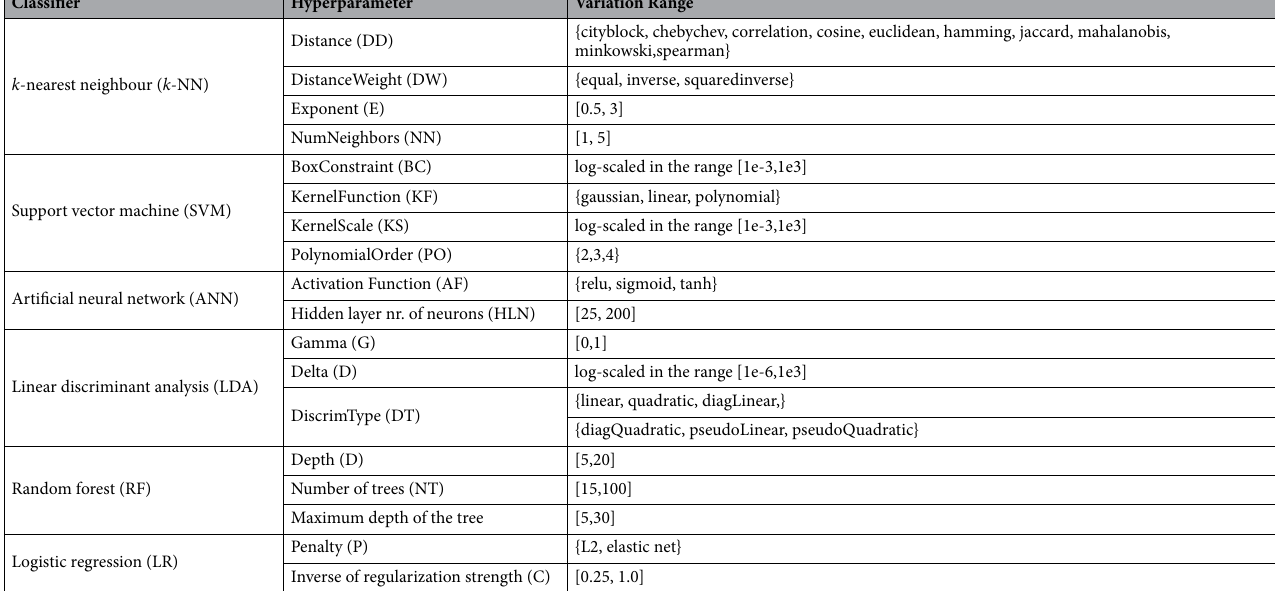
Table 2. Classifier optimized hyperparameters and variation